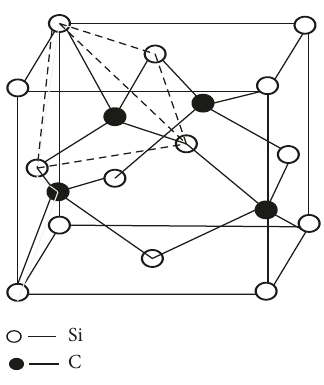
Figure 4: Schematic diagram of silicon carbide crystal